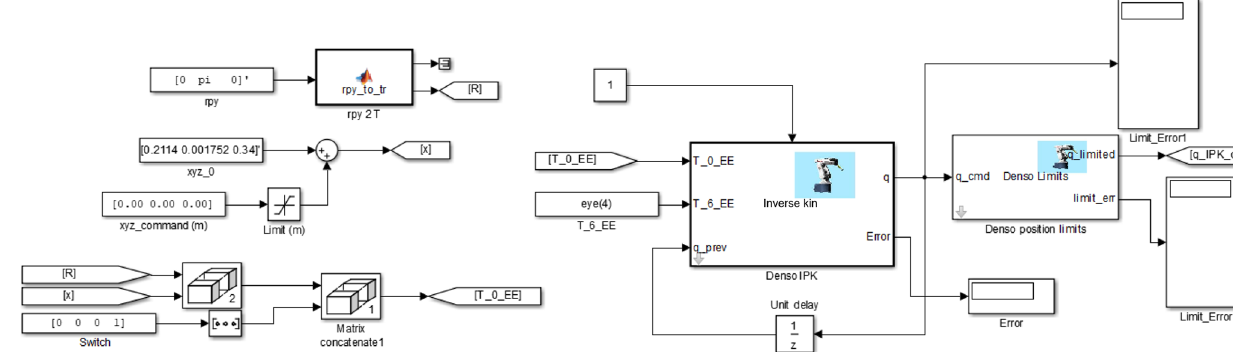
Figure 6. Simulink model of Denso Kinematics.